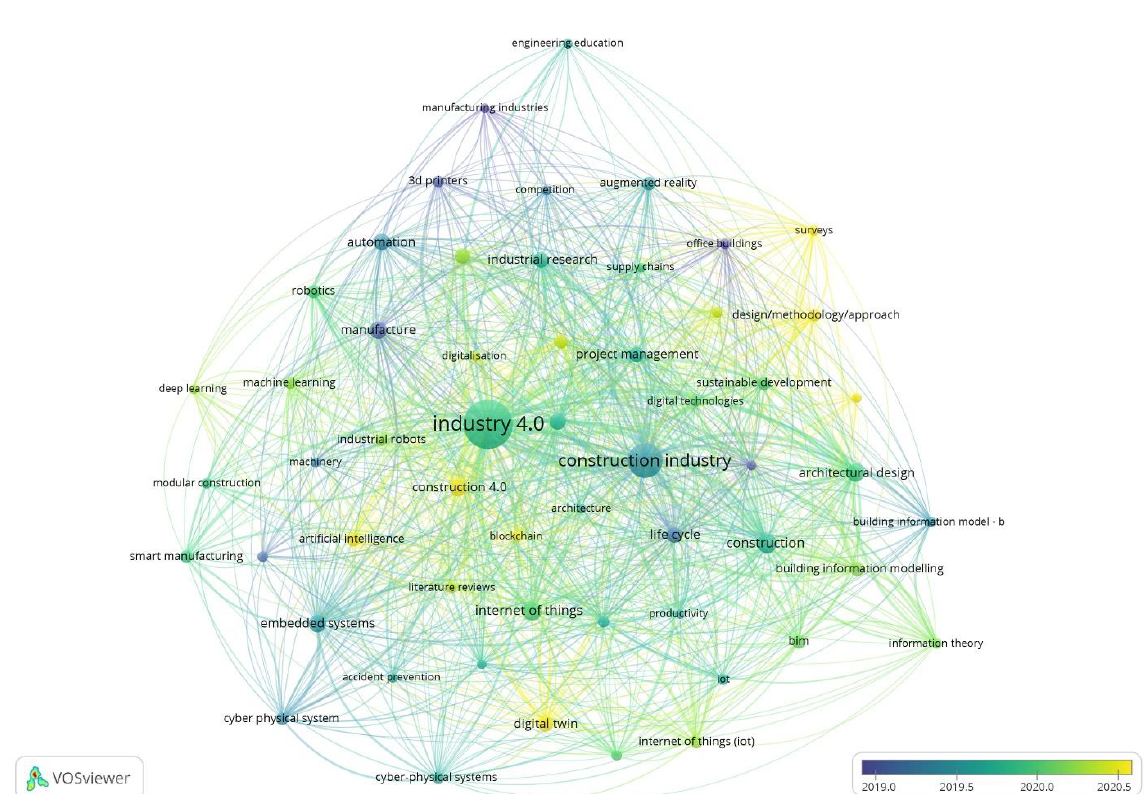
Figure 14. Time-based network map of co-occurring keywords showing the development of nodes based on the average year for Industry 4.0 in construction.